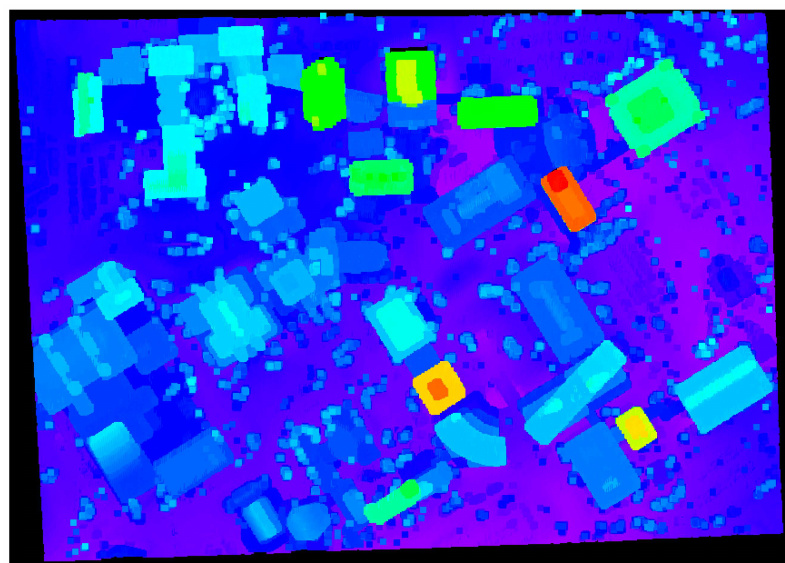
Figure 15. A large dataset over University of Calgary, Canada.